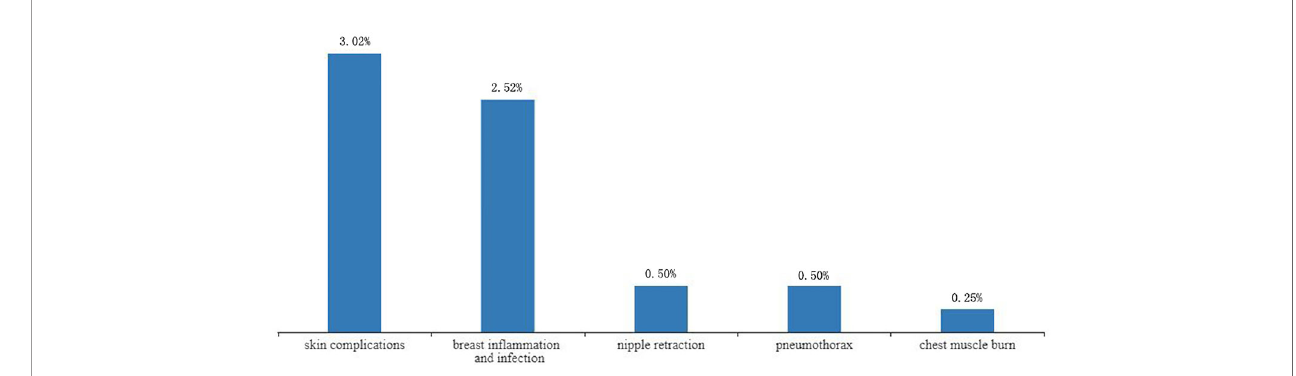
FIGURE 4 | Complications rate in patients receiving RFA with